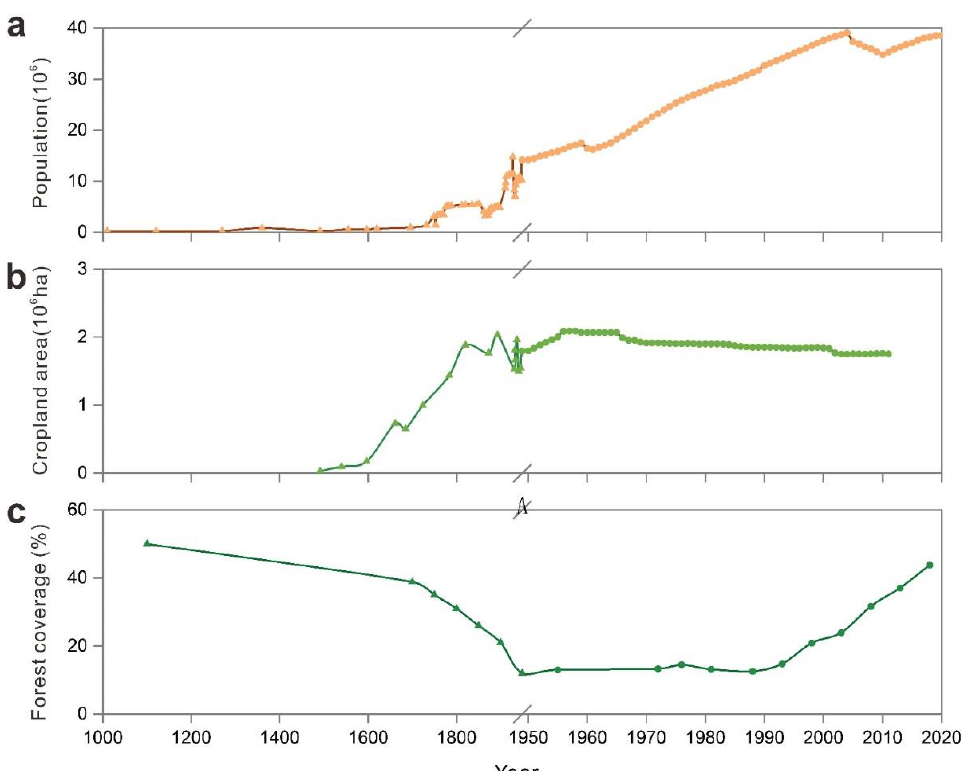
Figure 4. Changes in the SES component indicator over the past 1000 years: ( a ) population, ( b ) cropland area, and ( c ) forest coverage.